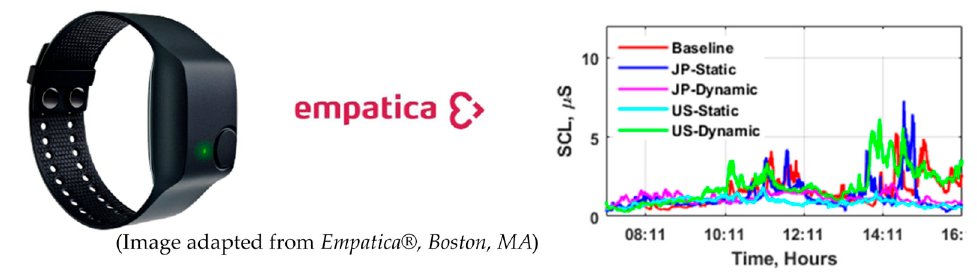
Figure 6. Photo of Empatica E4 and sample data for continuous stress measurements.